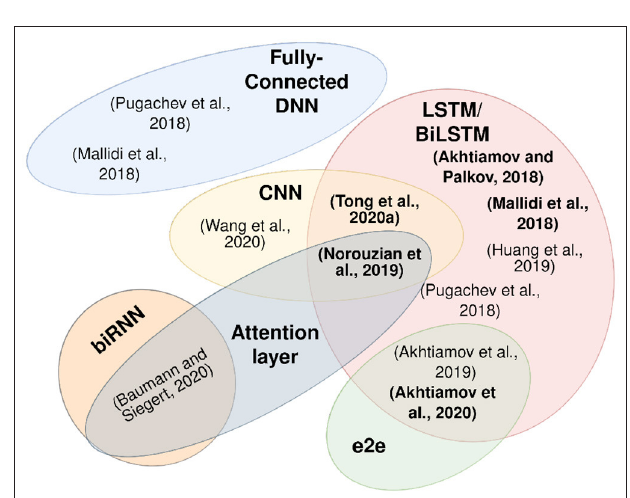
FIGURE 5 | Venn Diagram to illustrate the use of different deep-learning classification architectures in the identified studies. Studies in bold employ